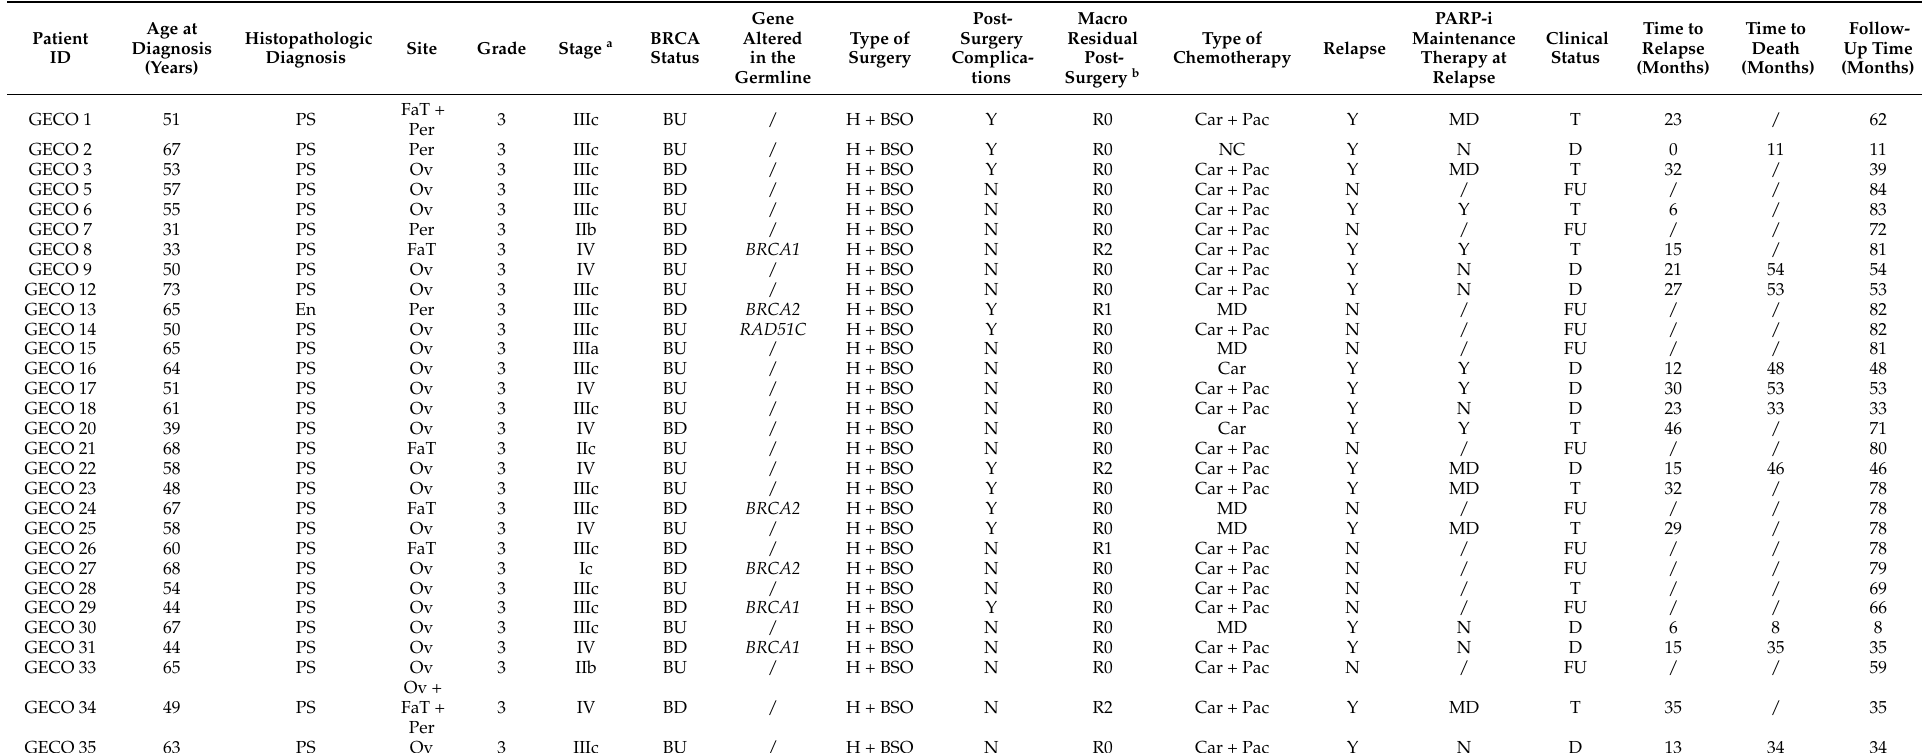
a FIGO classification. b Residual tumor (R) classification. PS = Papillary-Serous; En = Endometrioid; BU = BRCA undetected/unclear; BD = BRCA deficiency; H + BSO = Hysterectomy with Bilateral Salpingo-Oophorectomy; Y = Yes; N = No; Car = Carboplatin; Pac = Paclitaxel; NC = No Chemotherapy; MD = Missing Data; PARP-i = PARP-inhibitors; T = in therapy; D = Dead; FU = in